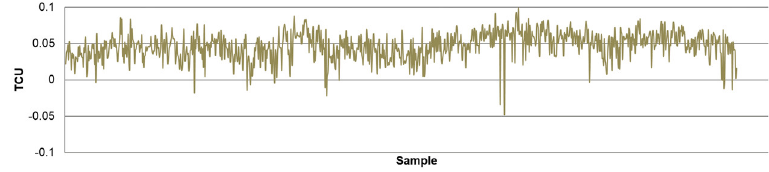
Figure A19. Prediction error of PMM model training dataset for TCU output variable.